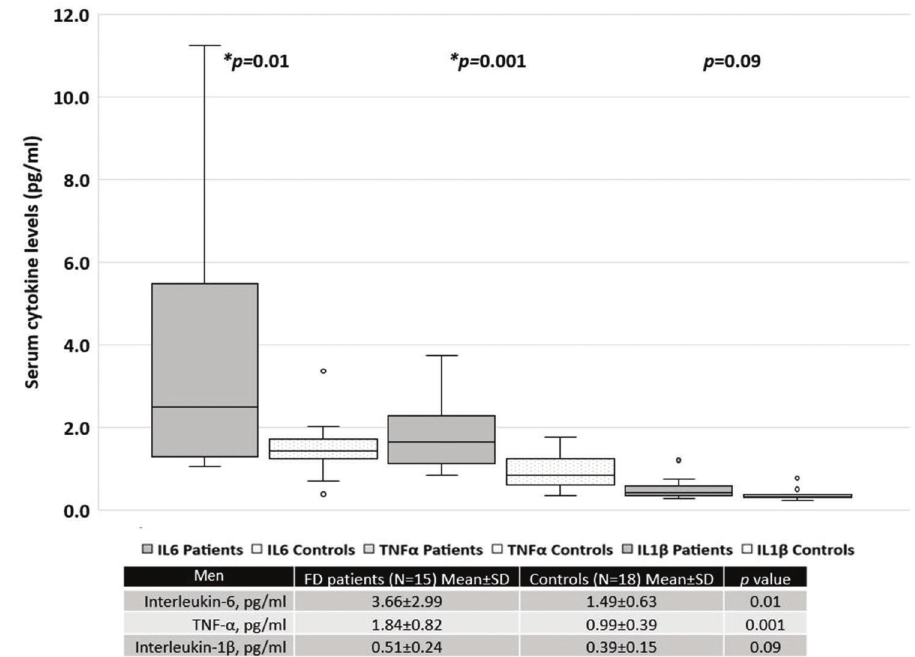
Figure 3 - Serum cytokine levels in men with FD versus those in the control